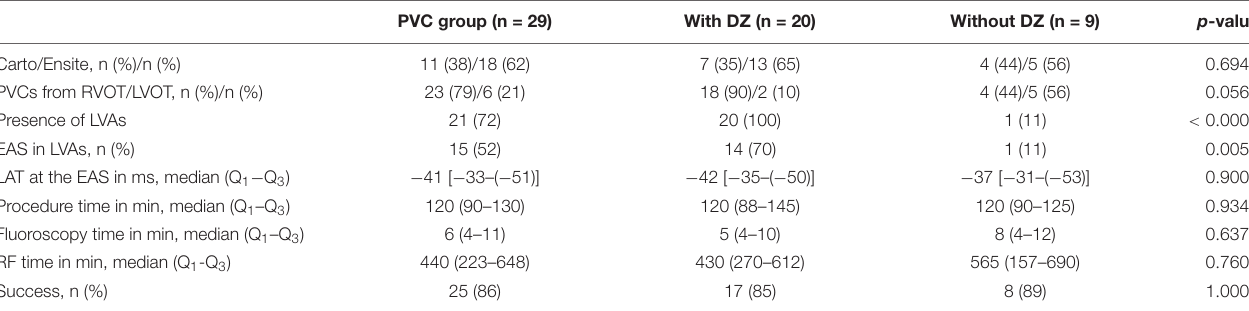
TABLE 4 | Activation mapping during PVCs and ablation data according to the presence of DZs. PVC group (n = 29) With DZ (n = 20) Without DZ (n =